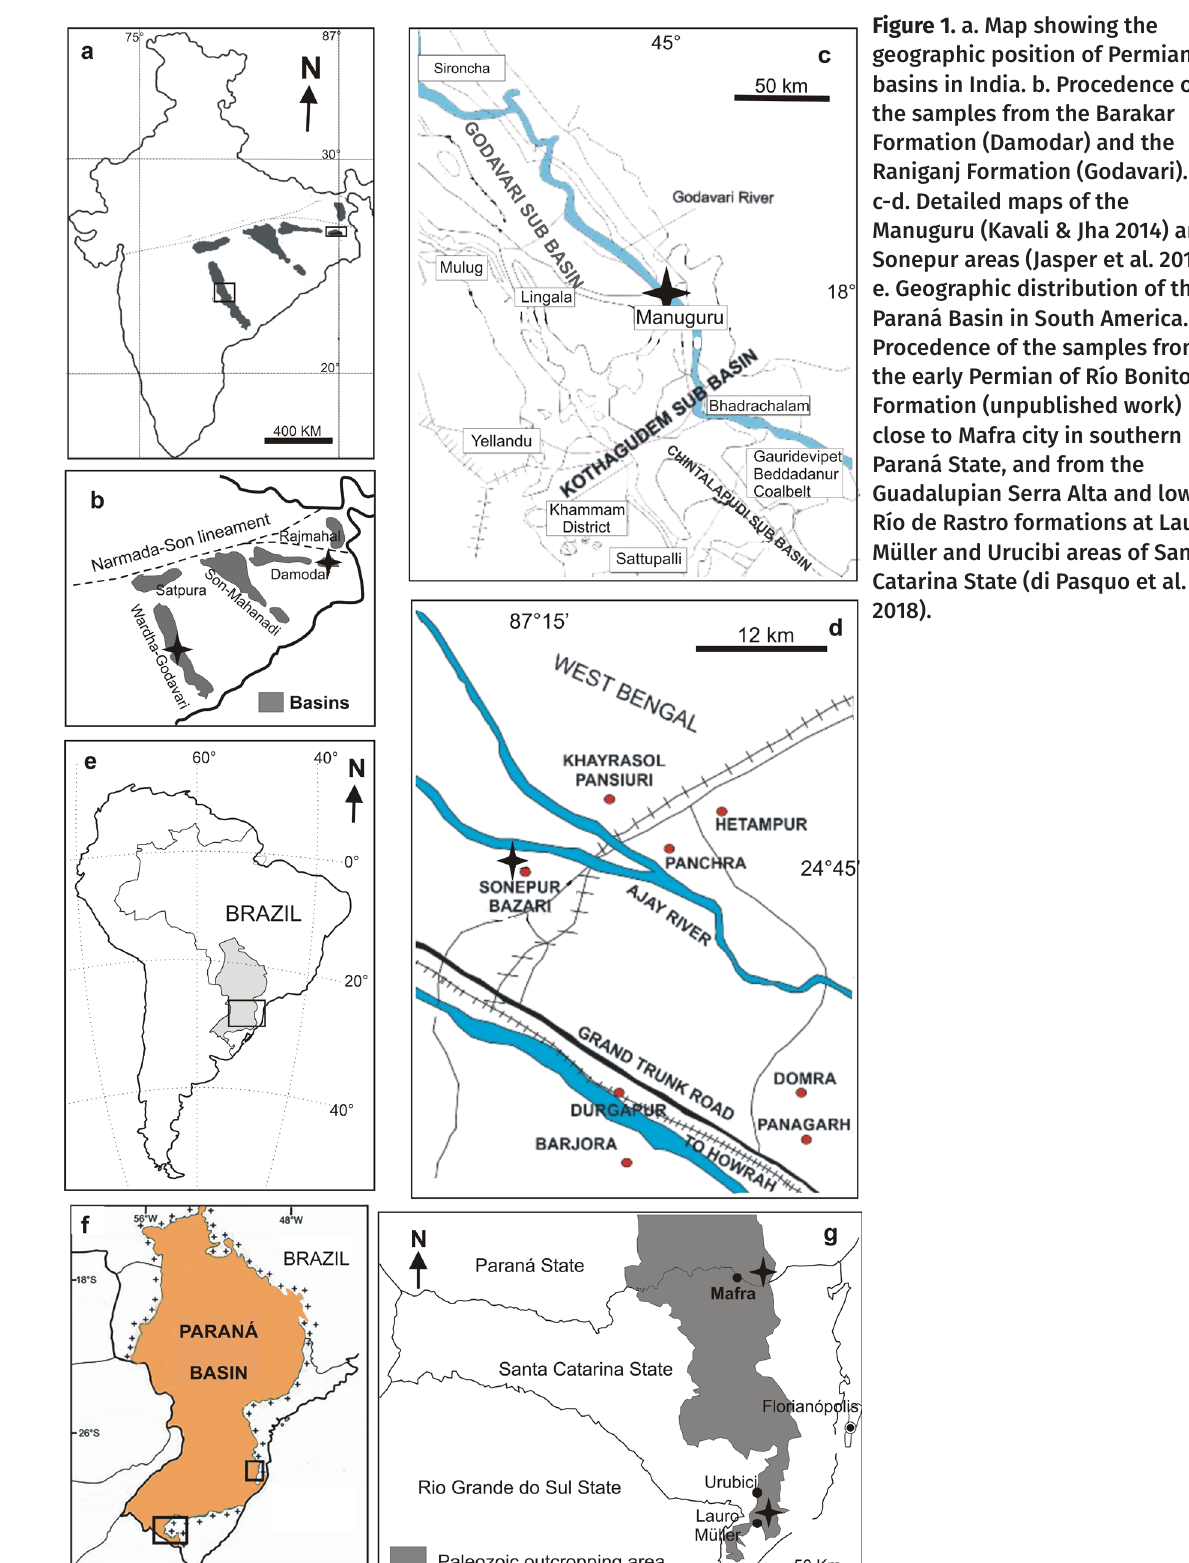
Figure 1. a. Map showing the geographic position of Permian basins in India. b. Procedence of the samples from the Barakar Formation (Damodar) and the Raniganj Formation (Godavari). c-d. Detailed maps of the Manuguru (Kavali & Jha 2014) and Sonepur areas (Jasper et al. 2012). e. Geographic distribution of the Paraná Basin in South America. f-g. Procedence of the samples from the early Permian of Río Bonito Formation (unpublished work) close to Mafra city in southern Paraná State, and from the Guadalupian Serra Alta and lower Río de Rastro formations at Lauro Müller and Urucibi areas of Santa Catarina State (di Pasquo et al.